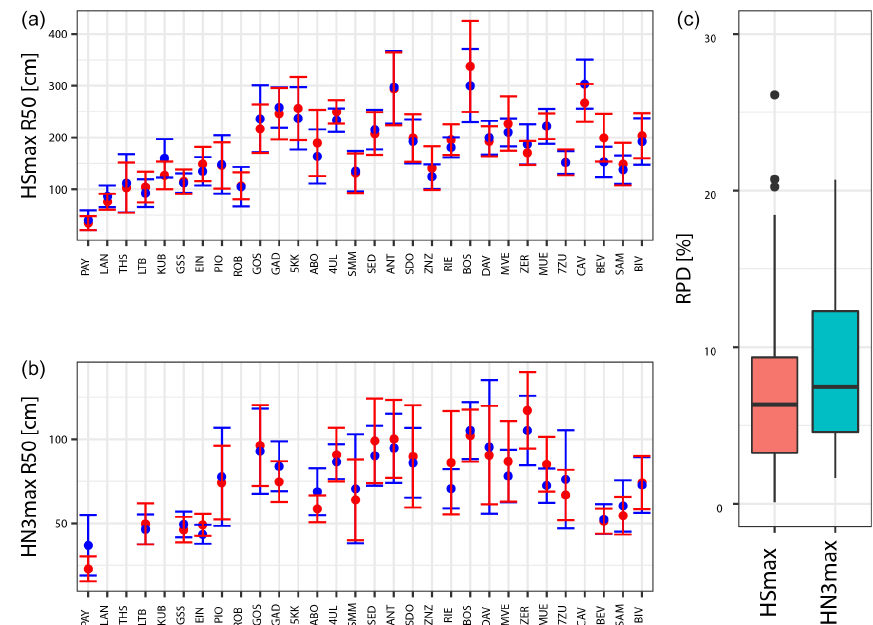
Figure 7. Return levels for seasonal maximum snow depth (HSmax) (top left) and maximum 3d new snow sum (HN3max) (bottom left) for 50-year return periods. MeteoSwiss (SLF) stations are coloured red (blue). The error bars indicate the 95% confidence intervals. Station pairs are ordered from left to right from low to high elevation. Relative percentage differences (RPDs) of return levels for HSmax and HN3max are depicted on the